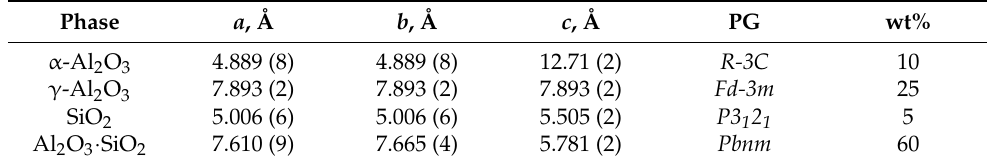
Table 1. Crystallographic parameters and quantitative content of phases in the PEO layer synthesized on the AK9 alloy in a slightly alkaline electrolyte of 3 g/L KOH + 2 g/L Na 2 SiO 3 composition.